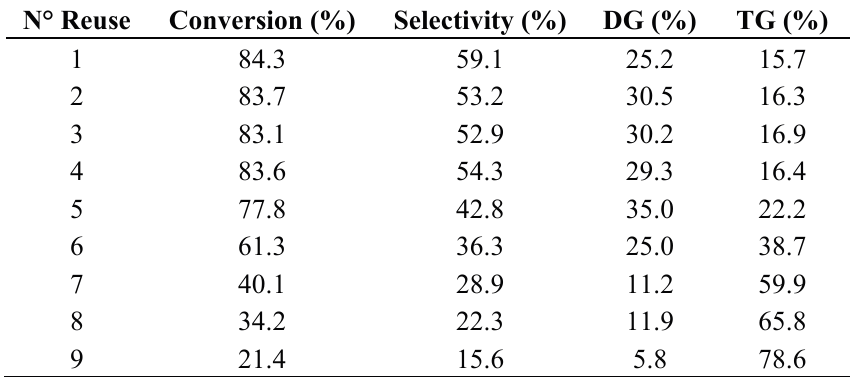
Table 5. Conversion (FAEE + MG + DG), selectivity (FAEE + MG) values as well as DG and TG composition, obtained in the successive reuse of Biolipase R covalently immobilized on sepiolite activated with the linker p -hydroxybenzaldehyde at pH 9, operating under standard conditions: 30 °C, with 12 mL of sunflower oil, 3.5 mL of absolute ethanol (1:6 oil/ethanol molar ratio) and pH 11, with 1.6 g of supported biocatalyst (15 wt % with respect to the oil used).